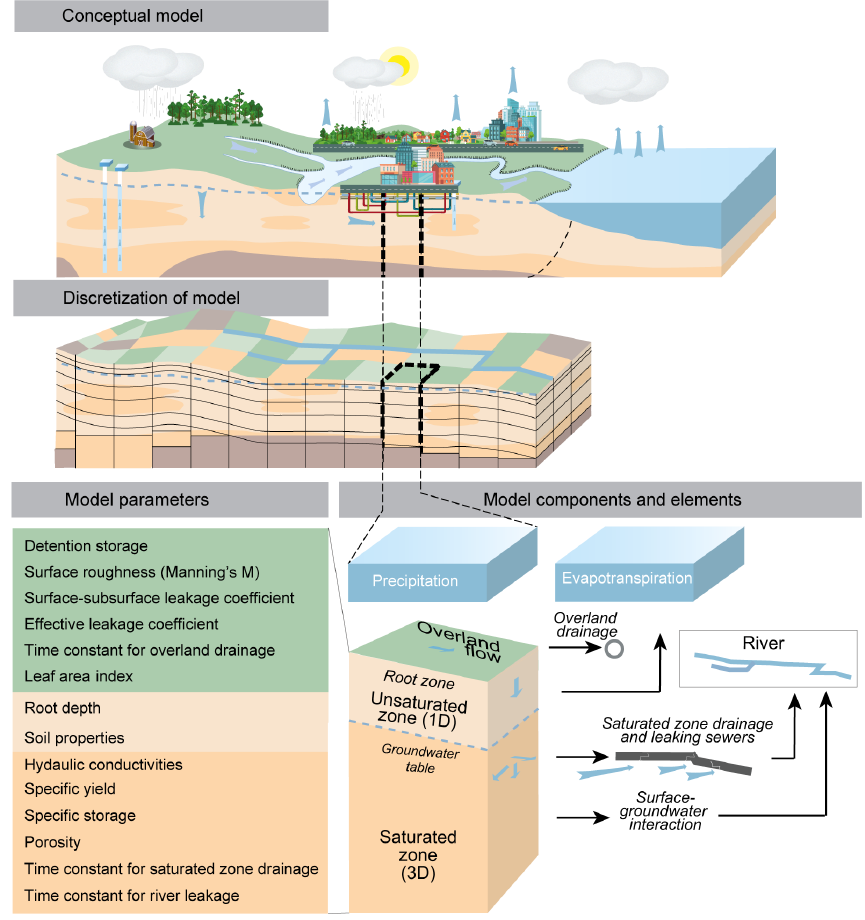
Figure 4. Illustration of the model setup for the hydrological